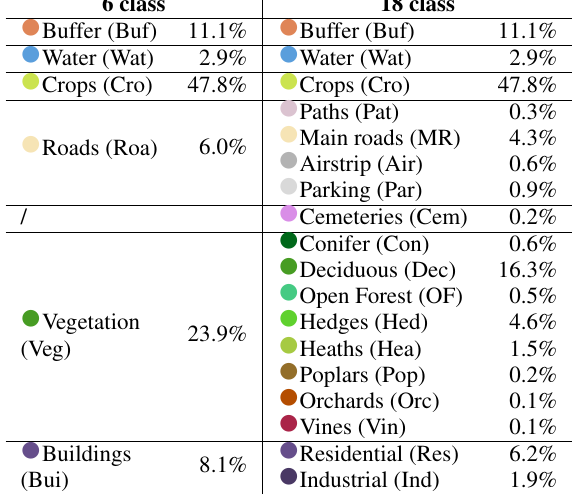
Table 1. 6 class and 18 class data distribution, acronyms and color